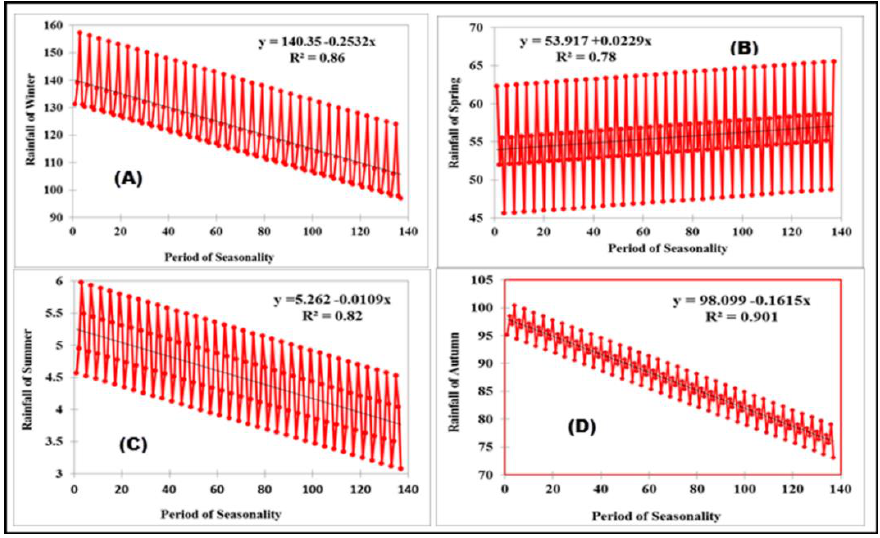
Figure 15. Temporal distribution of rainfall seasonal trends in Iran. ( a ) Winter; ( b ) spring; ( c ) summer; ( d )